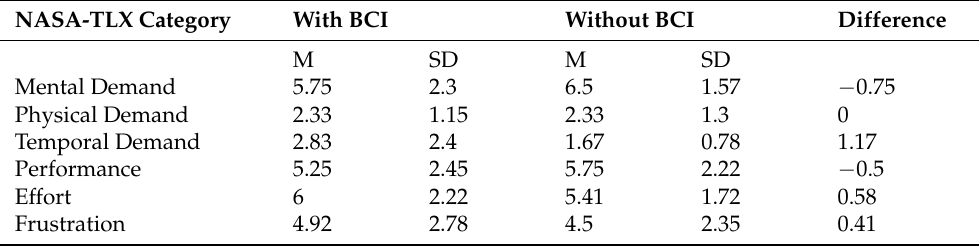
Table 2. Mean and standard deviation of the NASA-TLX